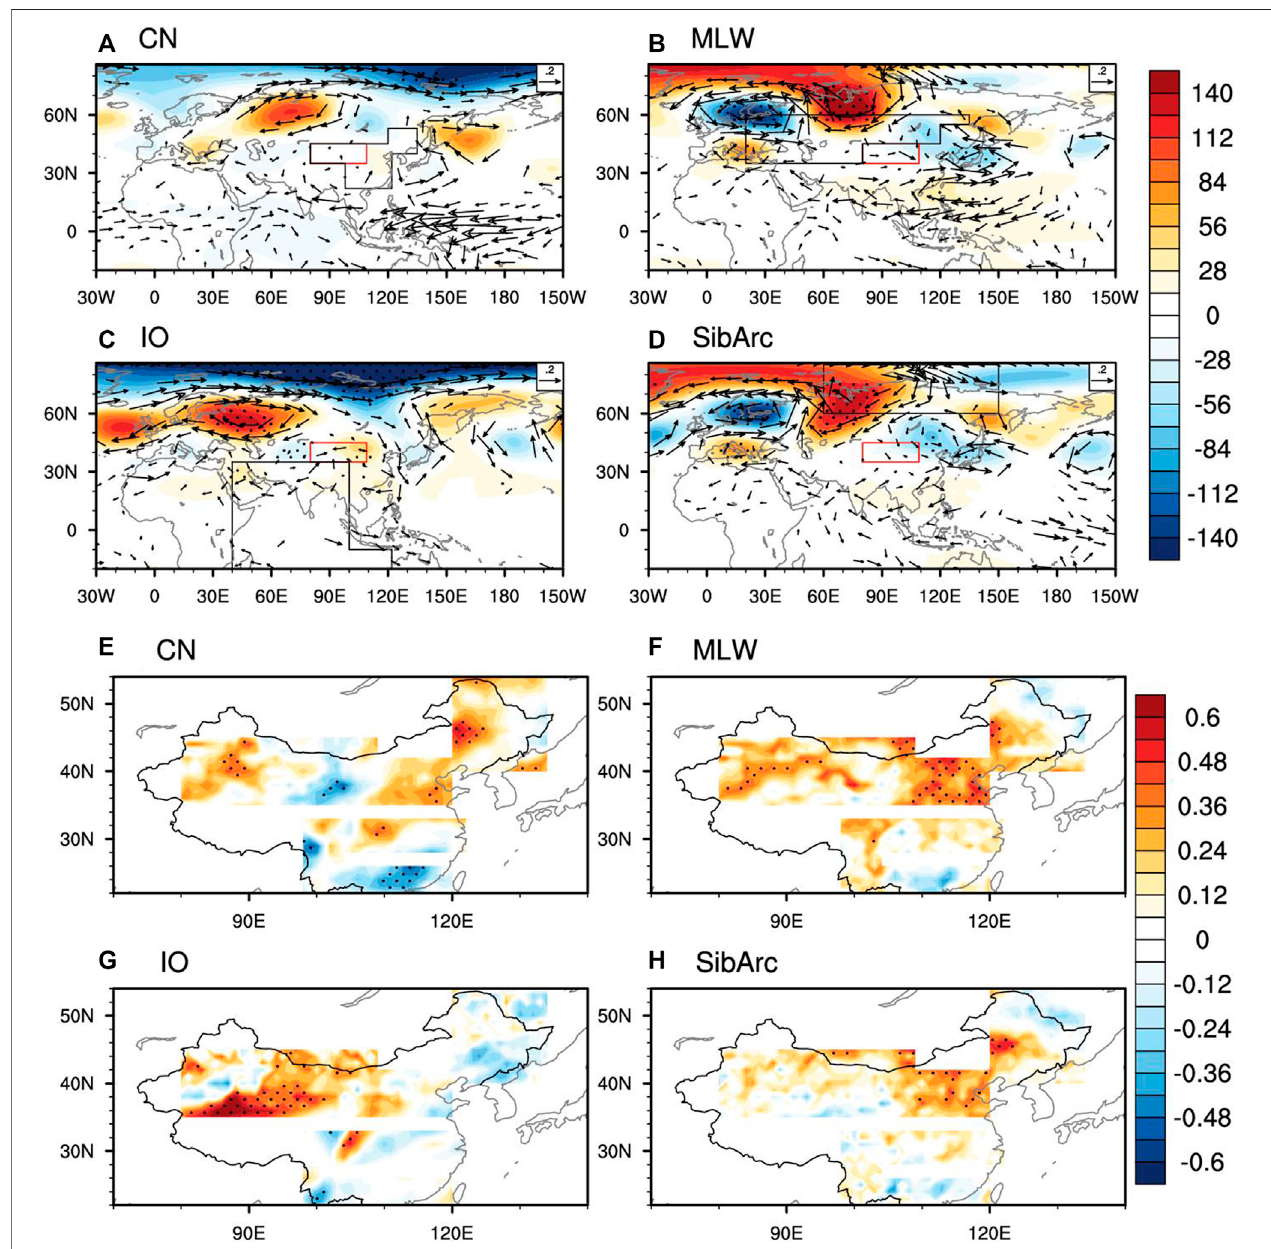
FIGURE 5 | (A – D) 500-hPa geopotential height and vertical accumulation of lower – middle tropospheric water vapor fl ux regressed against the CN, MLW, IO and SibArcsourcesofNWprecipitation.Panels (E – H) showthecorrelationcoef fi cientsbetweentheCN,MLWandSibArcmoisturesources,andthehigh-latitudewavetrain index, and between the IO moisture source and the midlatitude wave train index. The red (black) box denotes the target (moisture source) region. Stippling denotes the statistical signi fi cance of regression and correlation values at the 95% con fi dence level.